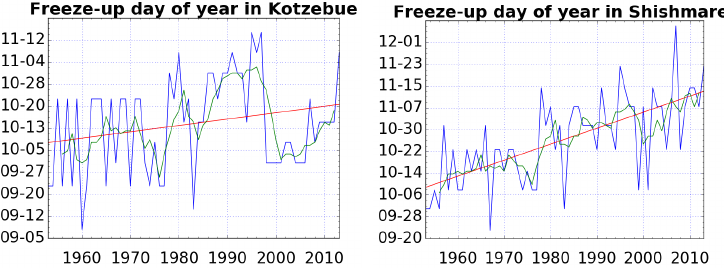
Figure 3. Trends in freeze-up day of year for Kotzebue and Shishmaref. Blue line is yearly freeze-up day, and green line indicates the 5-year running mean. Data are from HSIA. A